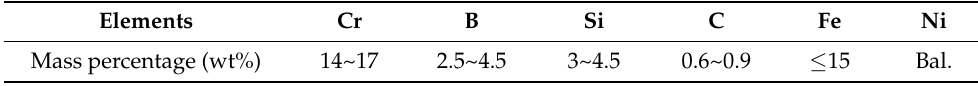
Table 2. Chemical compositions of Ni60 alloy.